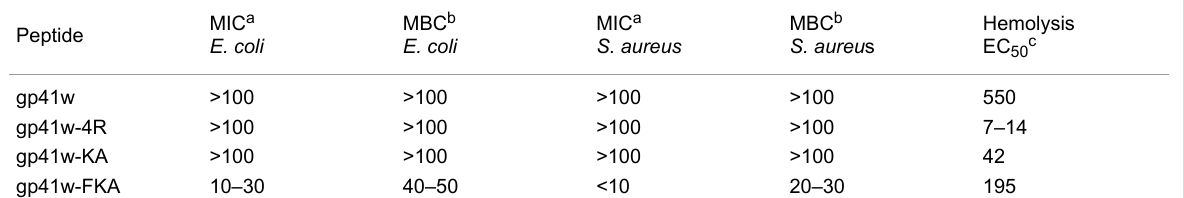
Table 1: Antimicrobial and hemolytic activities of the gp41w-derived peptides. All concentrations are presented as μ g/mL.